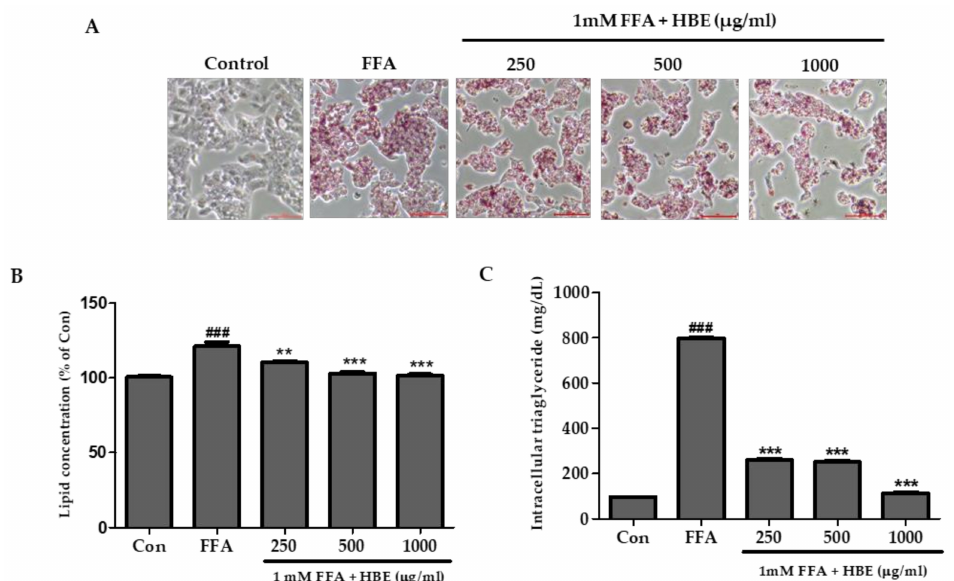
Figure 3. Effect of honeyberry extract (HBE) on Oil Red O staining and lipid accumulation in HepG2 cells. Lipid droplets in HepG2 cells were dyed red (magnification 200X). ( A ) Oil Red O staining images of HepG2 cells treated with 1 mM free fatty acids (FFA) and exposed to various concentration of HBE with 1mM FFA for 24 h. Control (Con) cells were incubated with 1% fat-free bovine serum albumin. ( B ) Quantitative lipid accumulation of Oil Red O contents at 500 nm. ( C ) Total intracellular triglyceride in HepG2 cells treated with HBE and 1 mM FFA. Data represent means ± SD. ### p < 0.001 vs. Con; ** p < 0.01, *** p < 0.001 vs.